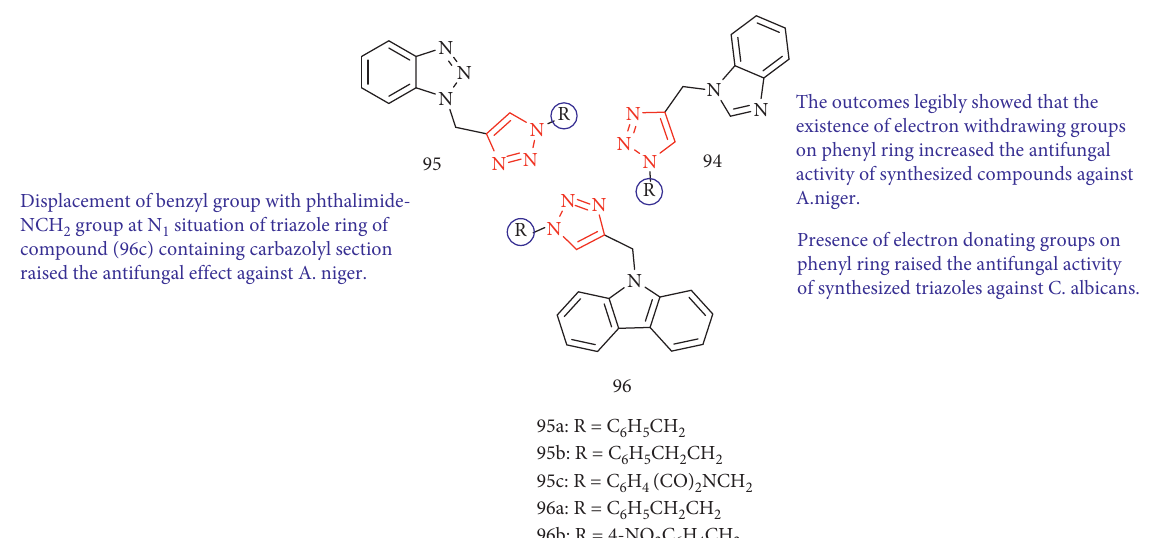
of benzyl group with phthalimide- NCH 2 group at N 1 situation of triazole ring of compound (96c) containing carbazolyl section raised the antifungal effect against A. niger.